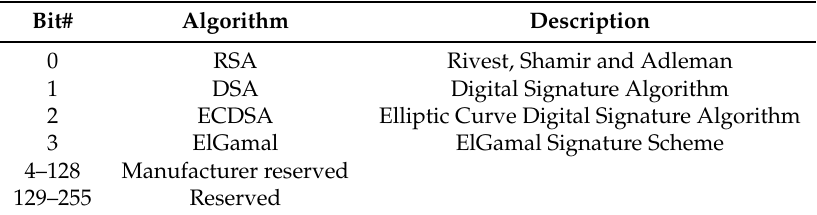
Table 2. IEEE 1451.0 security TEDS used encryption algorithm enumeration.